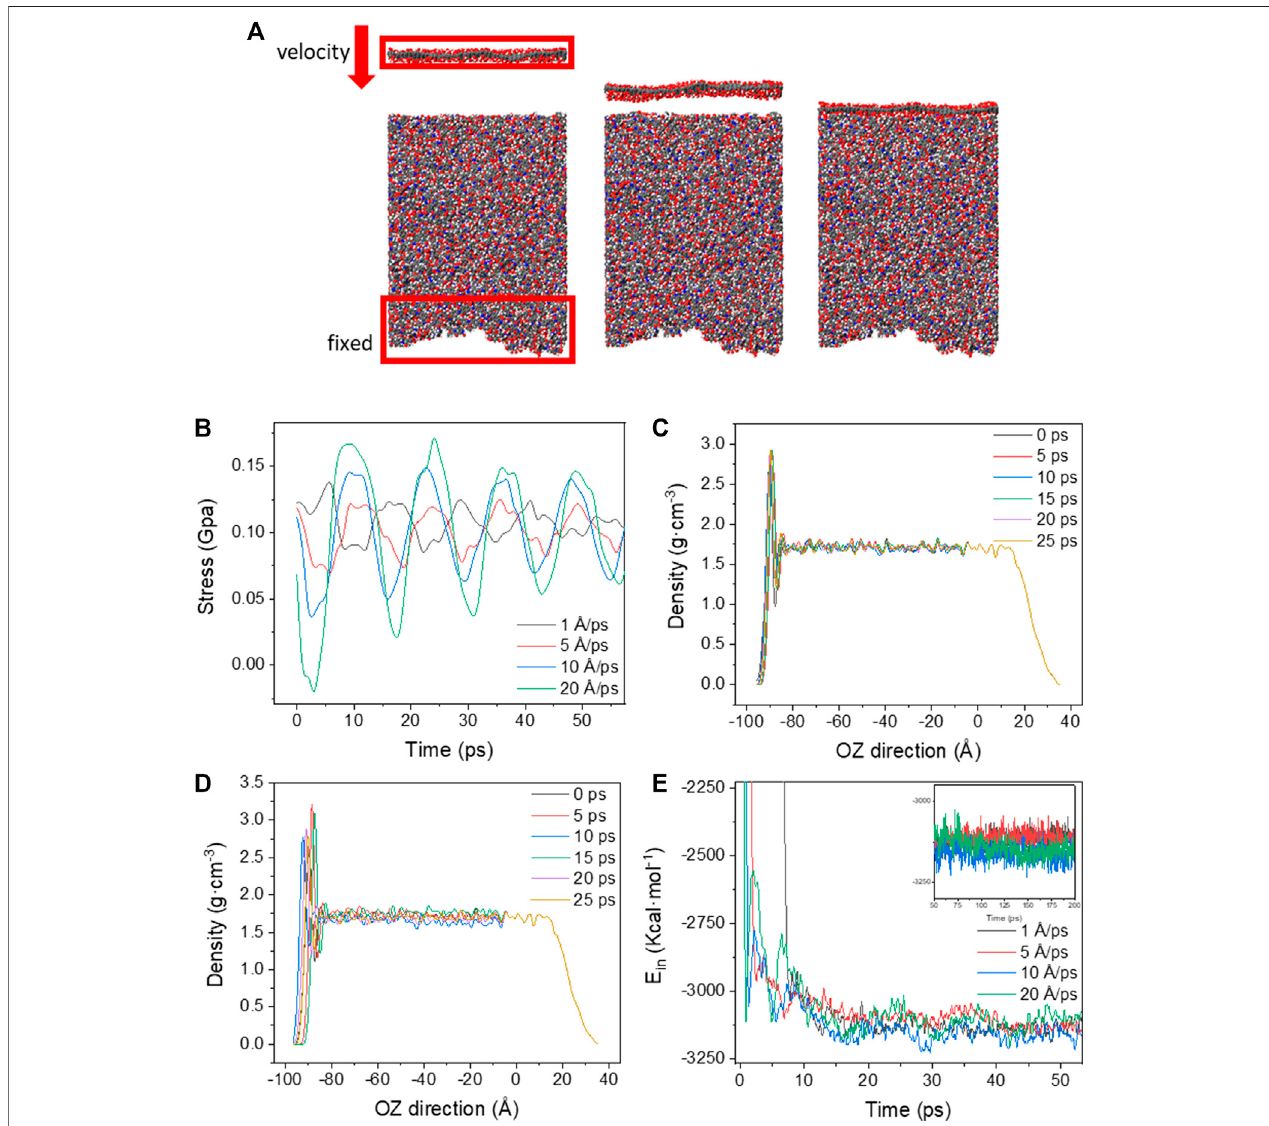
FIGURE 2 | (A) Scheme of shooting GO onto mPI; (B) stress of mPI/GO upon hitting; density pro fi les of mPI/GO system under (C) 1 Å/ps, d) 10 Å/ps; (E) E in change of mPI/GO system under different inkjet velocities upon hitting; inset: magni fi ed E in change from 50 to 200 ps.